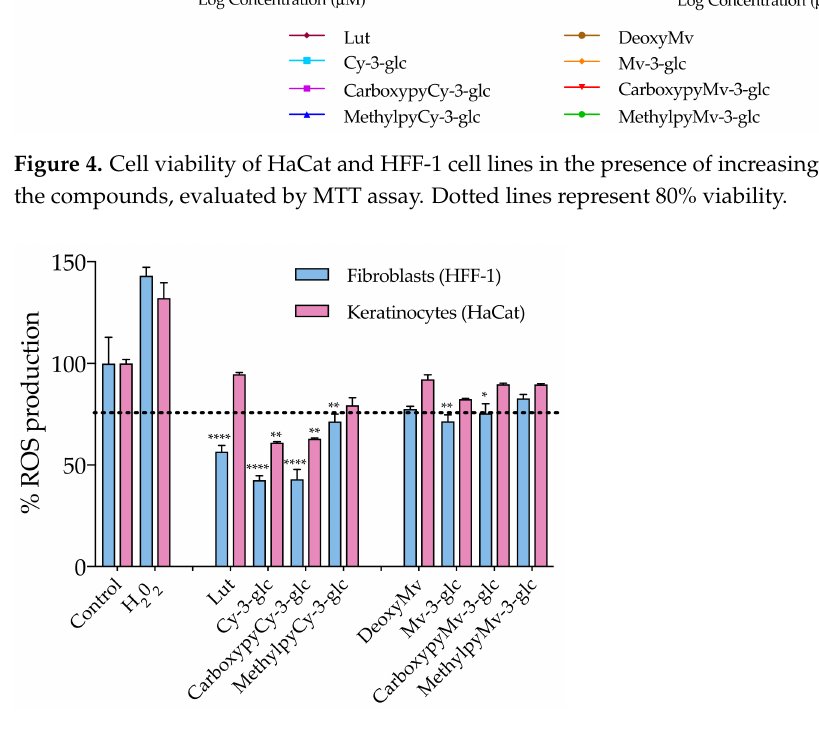
Figure 5. Effect of anthocyanins and related structures on ROS production in HaCat and HFF-1 cell lines, 24 h after incubation with 50 µ M of each compound. Hydrogen peroxide (50 µ M) was used as a positive control. Statistically significant differences between ROS production in the presence of the different compounds and control group are marked with asterisks: p < 0.05 (*), p < 0.005 (**) and p < 0.0001 (****). Dotted lines represent 80% ROS